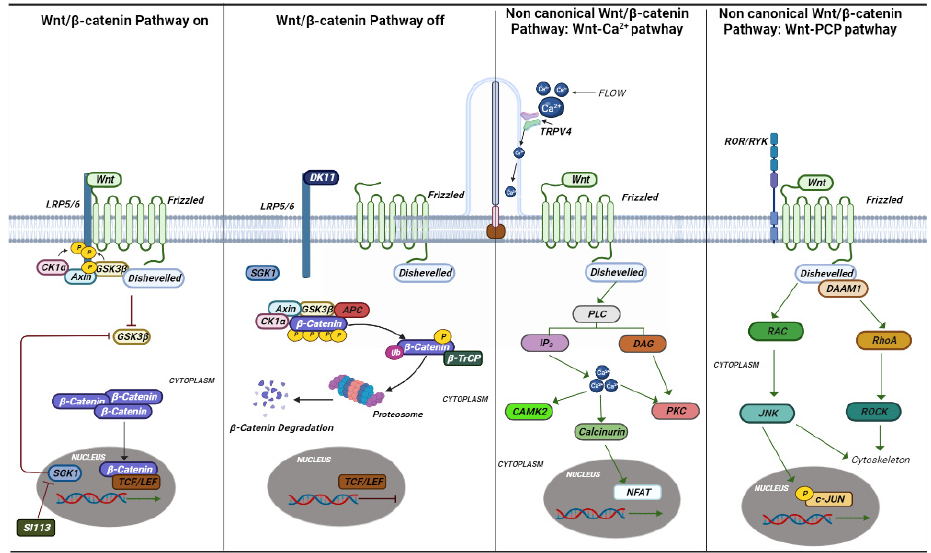
Figure 3. Canonical and non-canonical Wnt pathways. The canonical and noncanonical Wnt path- ways are depicted in the figure with the various genes and mechanisms that are activated. In cil- iopathies, several studies have shown that this pathway plays an essential role in their onset. Si113 is indicated; an SGK1 kinase inhibitor appears to have an effect on hydrocephalus caused by some